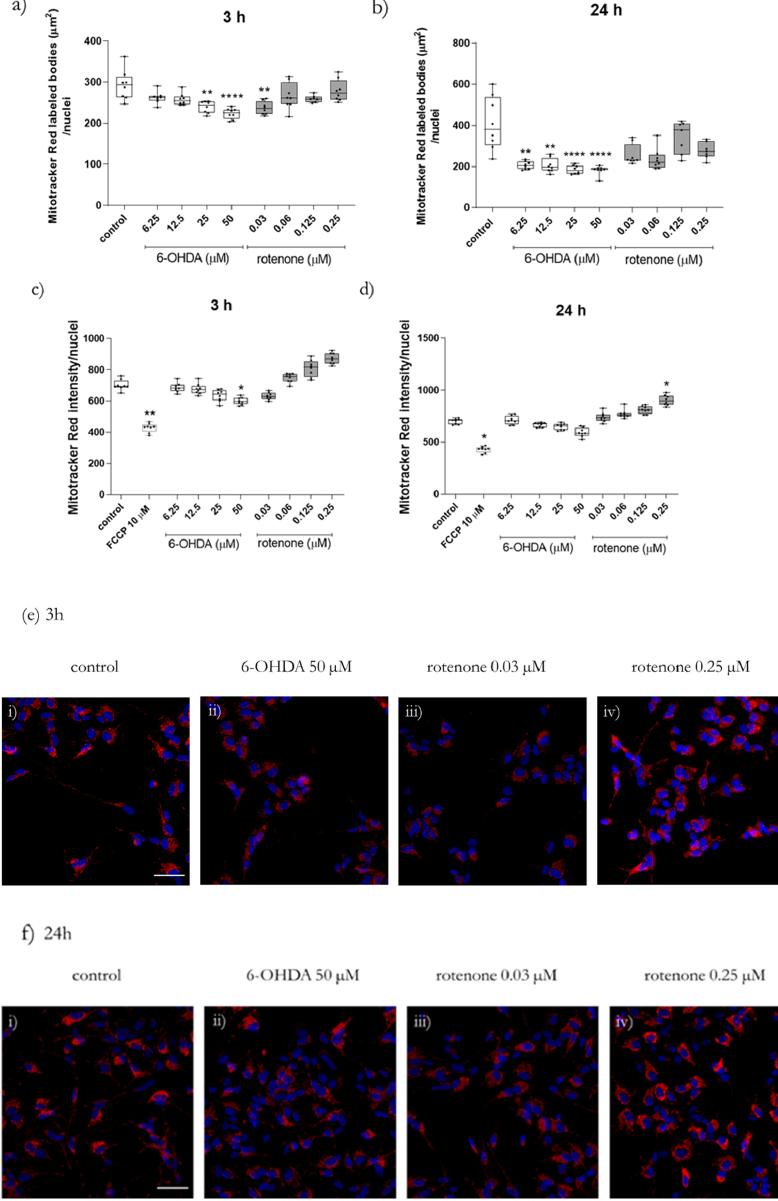
Figure 3. Non-toxic concentrations of 6-OHDA and rotenone prompted alterations in Mitotracker area and fluorescence intensity. Mitotracker Red labeled bodies area and intensity were evaluated in cells treated with 6-OHDA and rotenone for 3 h ( a , c ) and 24 h ( b , d ) with the mitochondrial membrane potential-dependent dye Mitotracker Red CMXRos. Data are represented in boxplots in which each dot represents an independent cell population ( n = 8), in duplicate. Kruskal–Wallis test (one-way ANOVA on ranks) pairwise (control vs. 6-OHDA or control vs. rotenone) was used to assess statistical significance, (*) p < 0.05, (**) p < 0.01, (****) p < 0.0001. Live-cell microscopy images of Mitotracker Red CMXRos labeling in SH-SY5Y cells were acquired using a 20 × objective in IN Cell Analyzer 2200. Scale bar = 50 µ m. Nuclei staining (Hoechst 33,342) is presented in blue, and Mitotracker Red CMXRos is presented in red ( e , f ). Representative images of cells treated for 3 h ( c ) or 24 h ( d ) with 50 µ M 6-OHDA ( ii ) or with 0.03 ( iii ) or 0.25 µ M ( iv ) rotenone are shown. Non-treated cells are presented in ( i ) in both ( e , f )